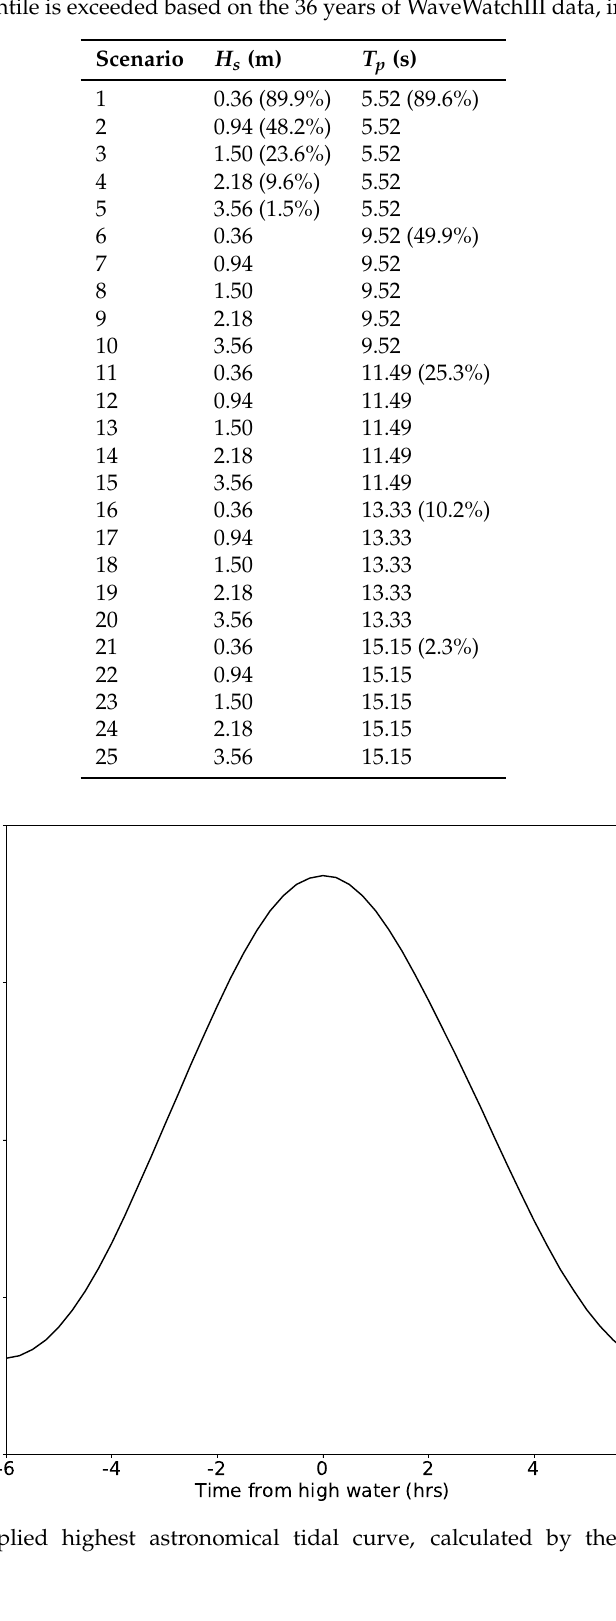
Table 2. The 10th, 50th, 75th, 90th and 98th percentiles of H s and T p in Figure 3, obtained from the U.K. Met Office WaveWatchIII model. The first occurrence of each value is accompanied by the percentage of the time the percentile is exceeded based on the 36 years of WaveWatchIII data, in parentheses.